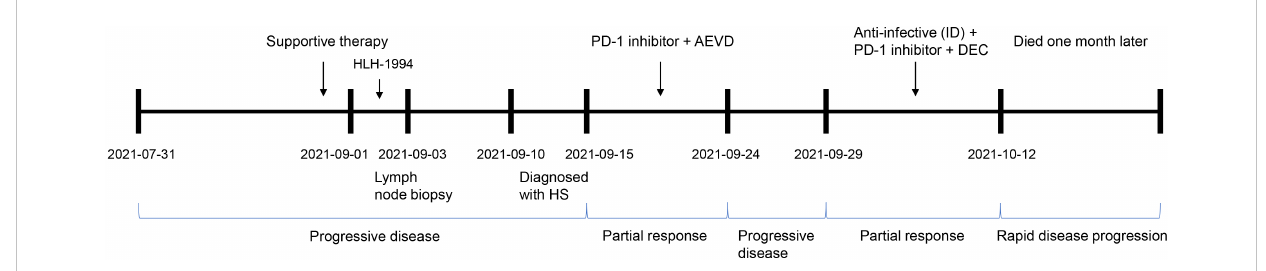
FIGURE 3 The clinical process comprising the patient ’ s treatment. Supportive therapy: anti-infective therapy, anti-allergic therapy, dexamethasone to reduce fever, and blood transfusion. PD-1 inhibitor, sintilimab; AEVD, epirubicin (50 mg on d 1), etoposide (100 mg on d 1), vincristine (3 mg on d 1) and dexamethasone (15 mg on d 1); ID, intravenous drip; DEC, dexamethasone (10 mg on d 0 – 14), etoposide (100 mg on d 1 – 2 and d 8) and chidamide (20 mg biw; i.e., every Wednesday and Saturday); PD, progressive disease; and PR, partial